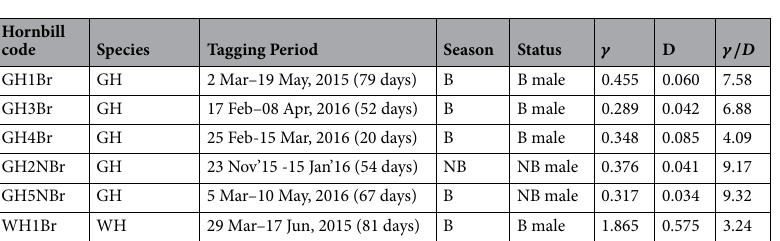
Figure 1. Data points and corresponding 100% Minimum Convex Polygons for different hornbills with respect to the landscape.